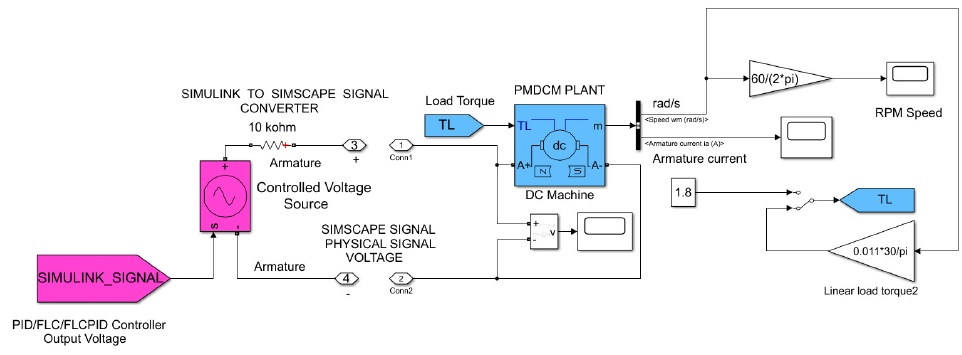
Figure 30. A 2HP 1750 RPM PMDCM—Simscape model (see [12]).